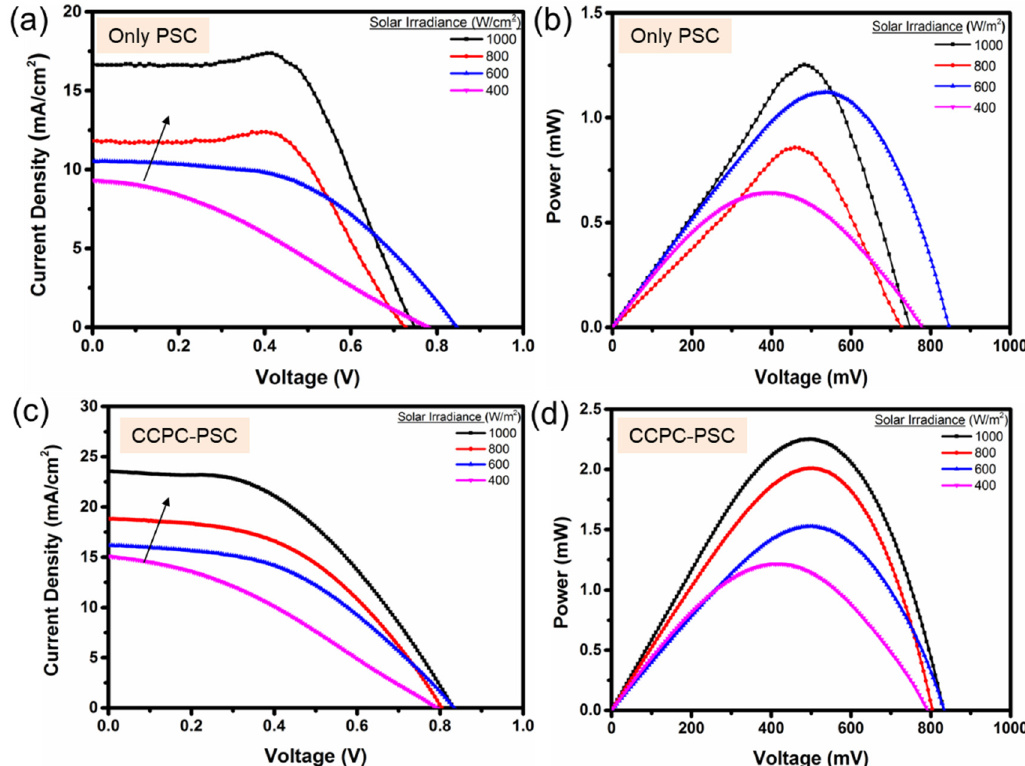
Figure 6. A plot of photovoltaic parameters variation such as ( a , c ) current-density vs circuit voltage (forward scan), and ( b , d ) power vs open-circuit voltage under different solar irradiance for the PSC and CCPC-integrated-PSC devices.